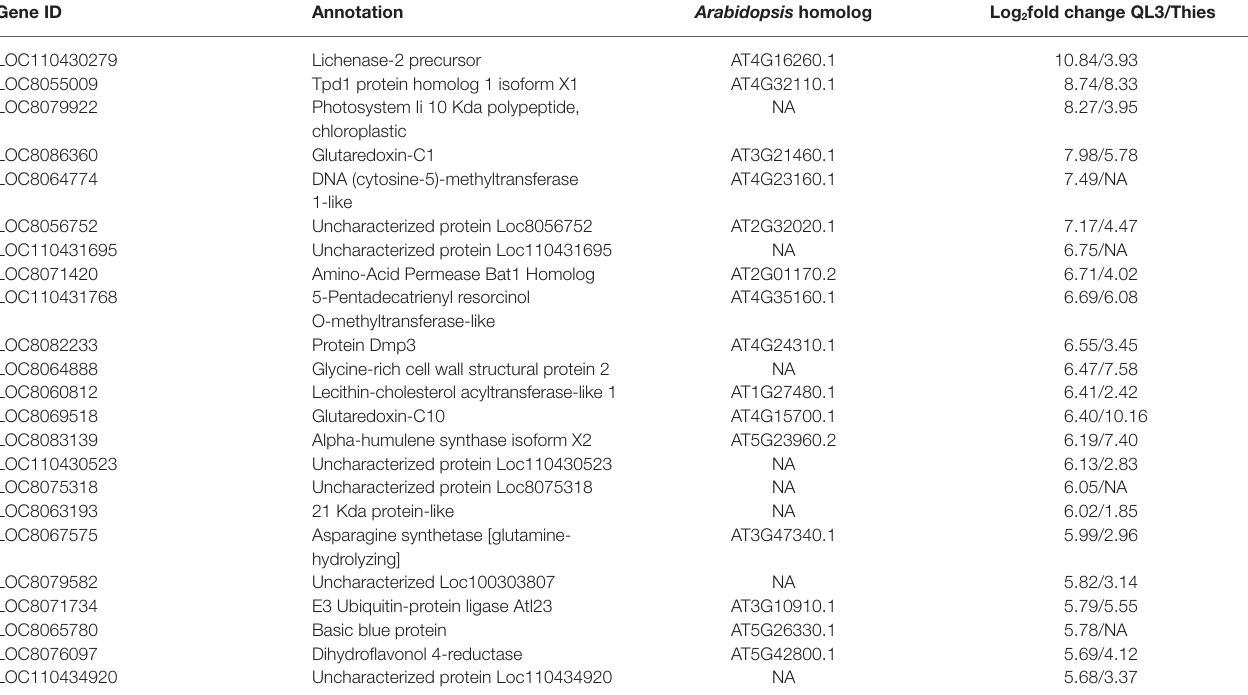
TABLE 3 | Top 25 DEGs upregulated in the resistant genotype QL3 by anthracnose infection and relative up or downregulation in Theis. Gene ID